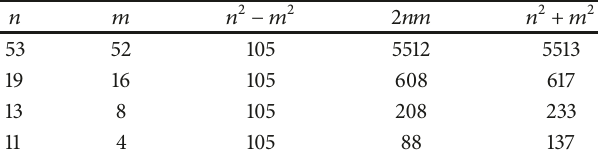
Table 3: Primitive Pythagorean triples with common leg 𝑎 =